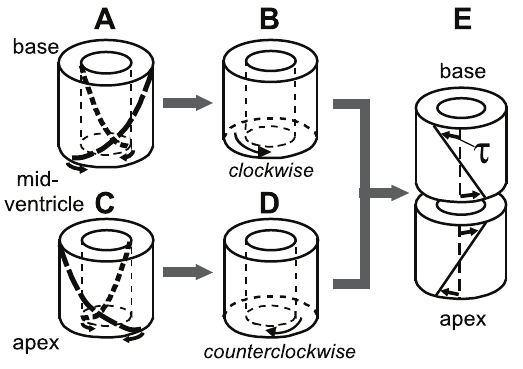
Figure 1. Relation between myofiber orientation and torsion. Top : At the base of the Situs Inversus Totalis (SIT) LV, myofibers follow a right-handed helical path at the sub-epicardium ( A ). Contraction of these myofibers, tends to rotate the midventricle in a clockwise direction with respect to the base, when viewed from the apex. The opposite is true for the sub-endocardium: myofibers follow a left- handed helical path, and contraction of these myofibers tends to rotate the midventricle in a counterclockwise direction with respect to the base ( A ). In general, a net clockwise rotation is measured at the base in SIT LV [6], indicating that epicardial myofibers dominate endocardial myofibers ( B ). Bottom : At the apex of the SIT LV, myofibers follow the same pattern as in the Situs Solitus (SS) LV. The dominant myofibers at the sub-epicardium follow a left-handed helical path ( C ). During contraction, a net counterclockwise rotation is measured in the apical region with respect to the midventricle of the SIT LV or with respect to the base in the SS LV ( D ). In fact, C and D both represent a whole SS LV. Finally, the torsion angle t in SIT is similar to SS at the apex and inverted at the base ( E